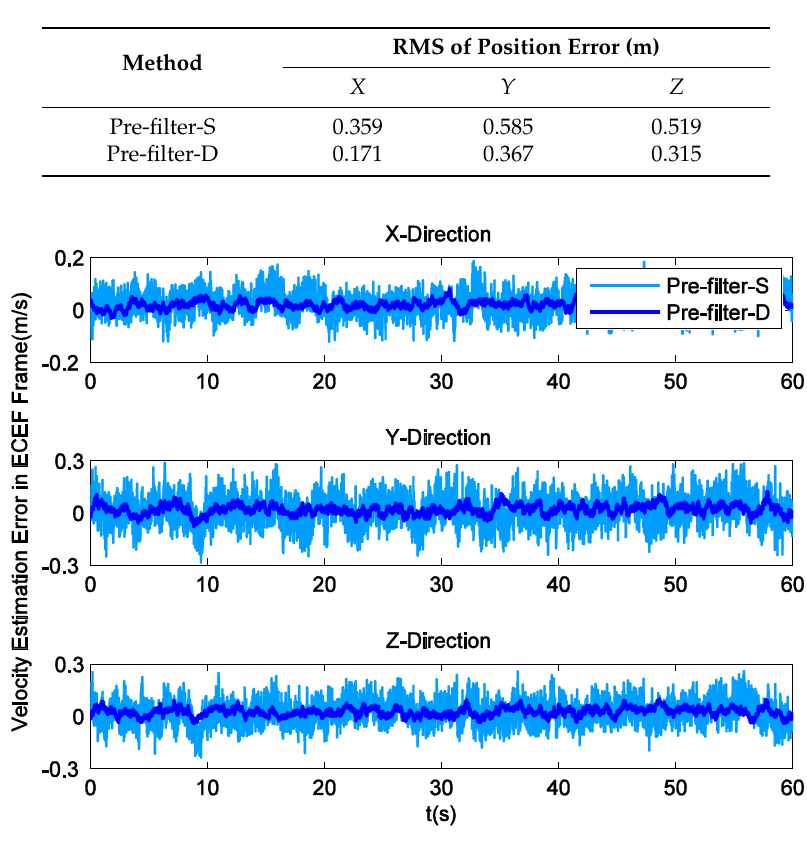
Figure 7. Velocity estimation errors with field data. Table 3. RMS of velocity estimation errors.